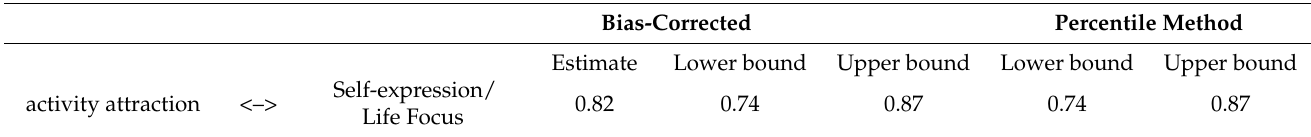
Table 7. Leisure Involvement Bootstrap with Correlation Coefficient 95% Confidence Interval.